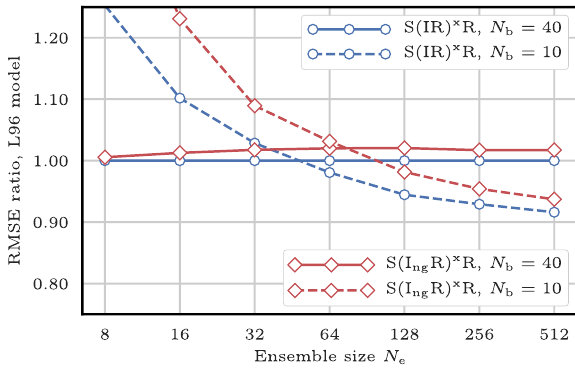
Figure 9. RMSE as a function of the ensemble size N e for the S(IR) x R and the S(I ng R) x R algorithms with N b = 40 and 10 blocks of size 1 and 4 grid points, respectively. The scores are displayed in units of the RMSE of the S(IR) x R algorithm with N b = 40 blocks of size 1 grid point.